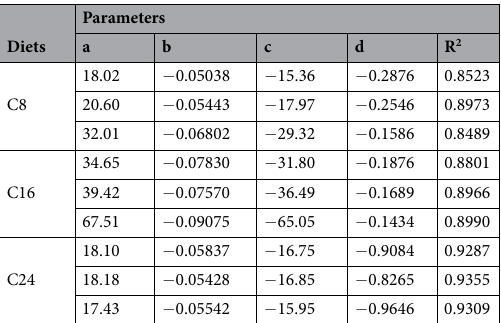
Table 3. Parameters in the regression equations after the glucose tolerance test. Coefficients of all parameter are with 95% confidence